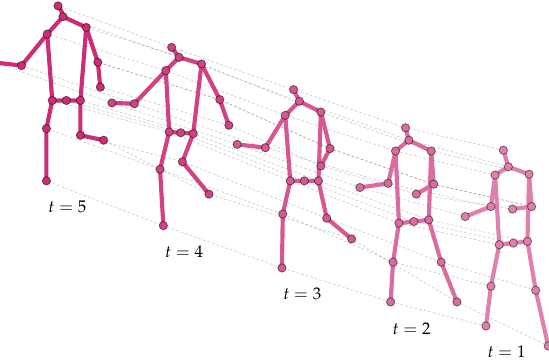
Figure 2. Exemplary skeleton sequence visualizing the movement of a person in five timesteps. The length of the sequence depends on the chosen algorithm. Each timestep consists of 15 keypoints, which again is just exemplary and depends on the chosen pose model. However, the basic shape of a person is recognizable. The figure is based on [19].